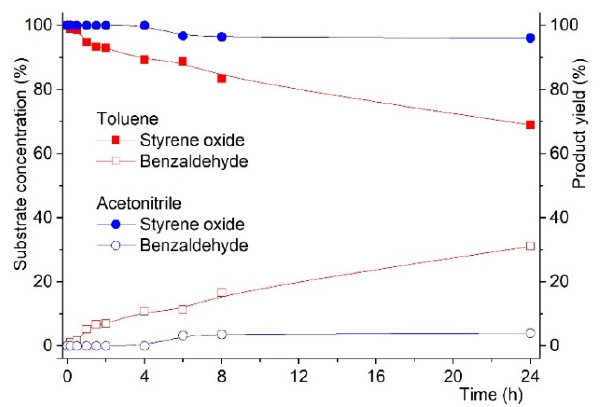
Figure 4. Reaction kinetics for the oxidation of styrene oxide to benzaldehyde in the presence of MCM AW . Reactions were carried out using substrate:oxidant mol % ratio of 100:200 with 50 mg of catalyst using acetonitrile or toluene as solvent and at 3535 K.